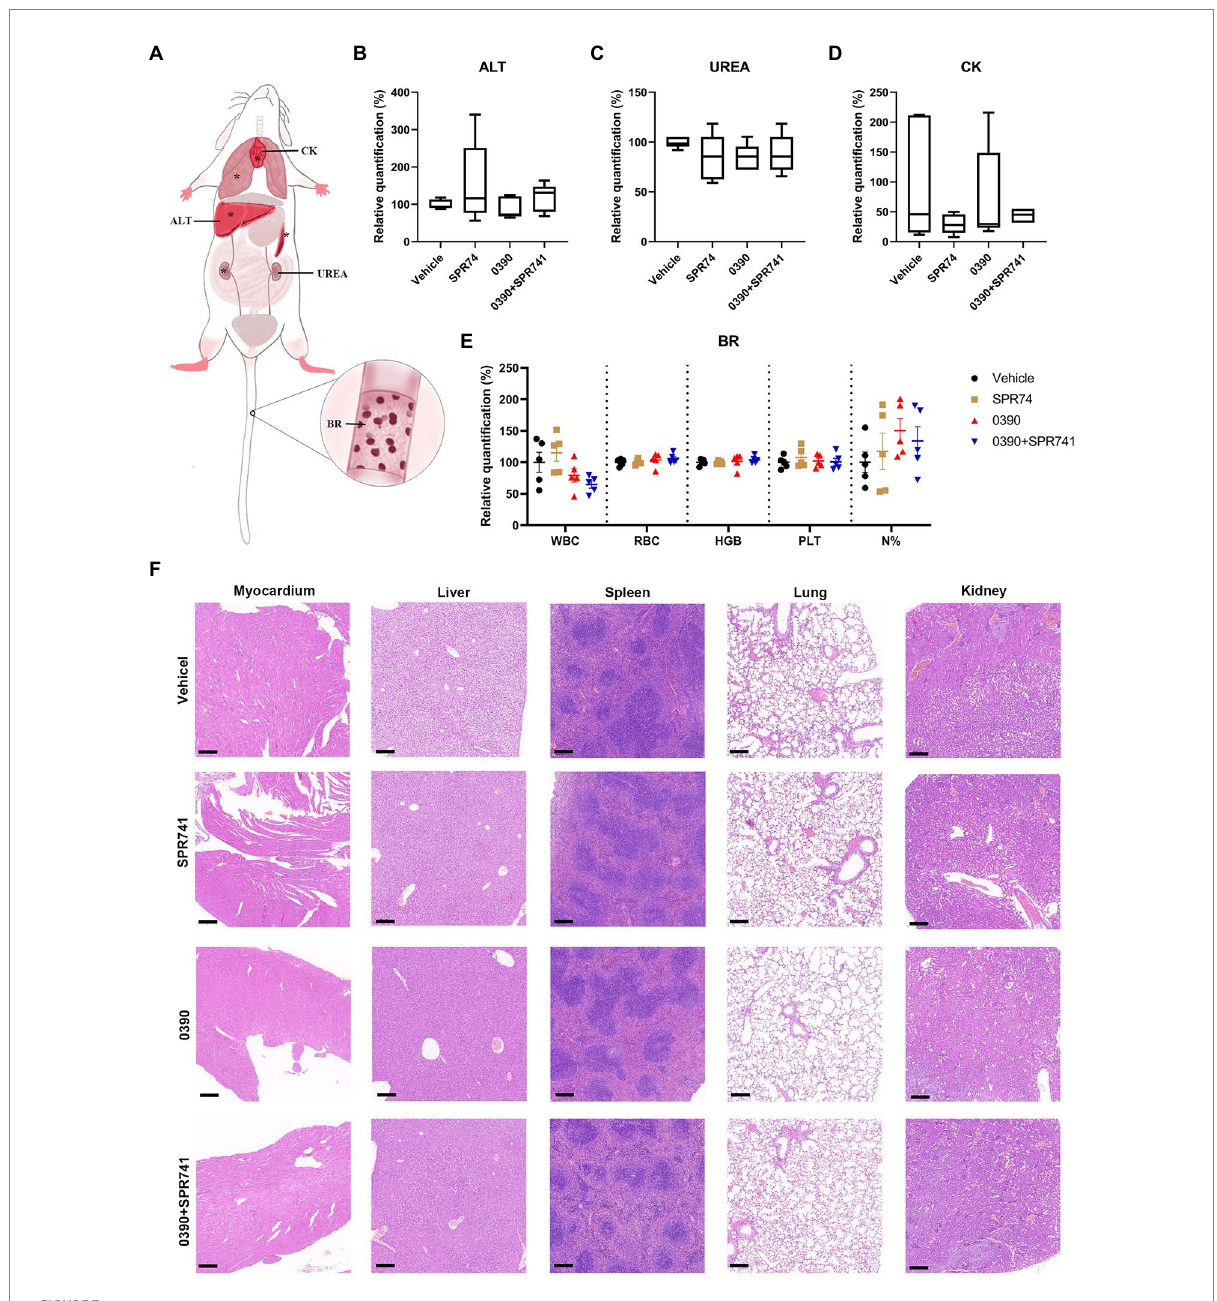
FIGURE 7 Acceptable in vivo tolerance of 0390 and SPR741 in combination. (A) Whole body pattern diagram of mice, which is labeled with several biomarkers that reflect corresponding organic functions, blood routine analysis. The organs labeled with ‘*’ were assessed by H&E staining. For in vivo toxicity observation, mice ( n = 5 mice/group) were treated with 0.5% DMSO (Vehicle), 20 mg/kg 0390, and 20 mg/kg SPR741 alone or in combination, respectively. (B) Serum alanine transaminase (ALT) quantification for liver function assessment. (C) Serum urea (UREA) quantification for renal function assessment. (D) Serum creatine kinase (CK) quantification for myocardial function assessment. One-way ANOVA indicted no statistically significant difference among groups. (E) Blood routine parameters, including white blood cell counting (WBC), red blood cell counting (RBC), hemoglobin amount (HGB), platelet counting (PLT), and neutrophil classification (N%). One-way ANOVA indicted no statistically significant difference among groups. (F) H&E staining of myocardium, liver, spleen, lung, and kidney. Scale: 200 μ